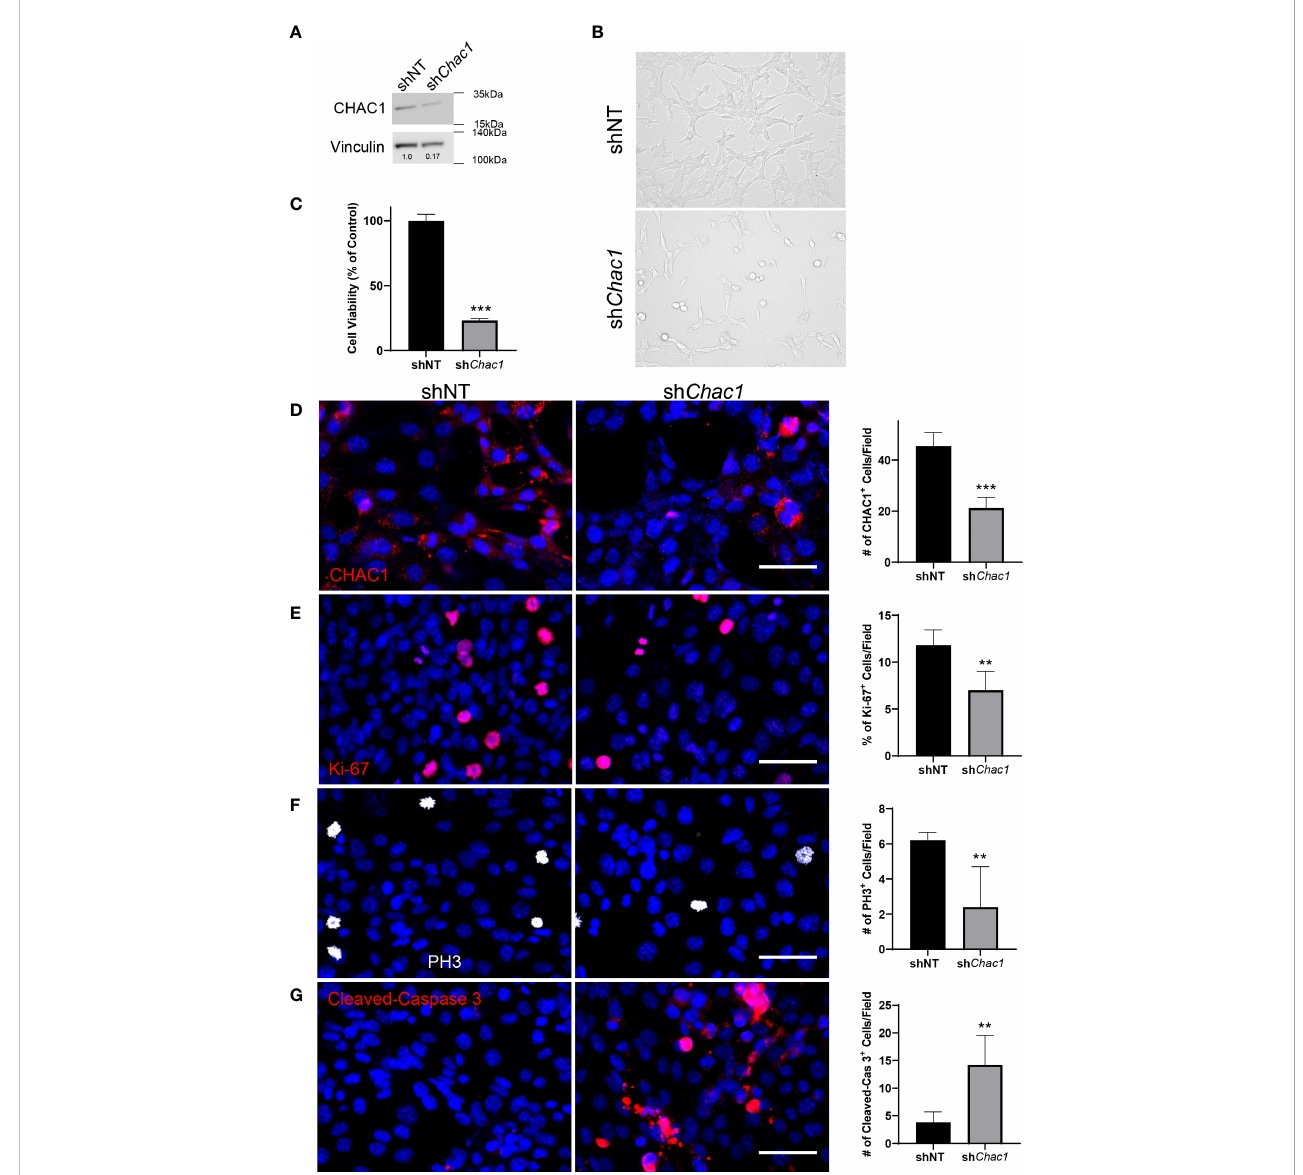
FIGURE 6 Depletion of Chac1 decreases rhabdomyosarcoma tumor cell growth. (A) , Knockdown of Chac1 in Rd76-9 RMS cells using sh Chac1 ef fi ciently decreases CHAC1 protein levels compared to shNT control, shown using Western blot. (B) , Bright fi eld images of CHAC1-de fi cient Rd76-9 tumor cells show increased number of fl oating cells and decreased number of attached cells compared to control at 24 hours after seeding. (C) , Depletion of CHAC1 reduces the percent of vialble tumor cells compared to control at 48 hours after seeding. The graph shows the percentage of live cells compared to shNT control. (D) , Knockdown of Chac1 in Rd76-9 RMS cells reduces the number of CHAC1 + (red) cells compared to shNT control. (E) , Knockdown of Chac1 in Rd76-9 RMS cells reduces proliferation (Ki-67, red) and mitosis ( F , PH3, white) compared to shNT. (G) , Knockdown of Chac1 induces apoptosis in Rd76-9 tumor cells (Cleaved-Caspase 3, red) compared to shNT control. 5 random fi elds per sample were used to quantify the numbers of CHAC1 + , Ki-67 + , PH3 + and Cleaved-Caspase 3 + cells per group. Values are shown as mean ± SD. ** P <0.01; *** P <0.001. Scale